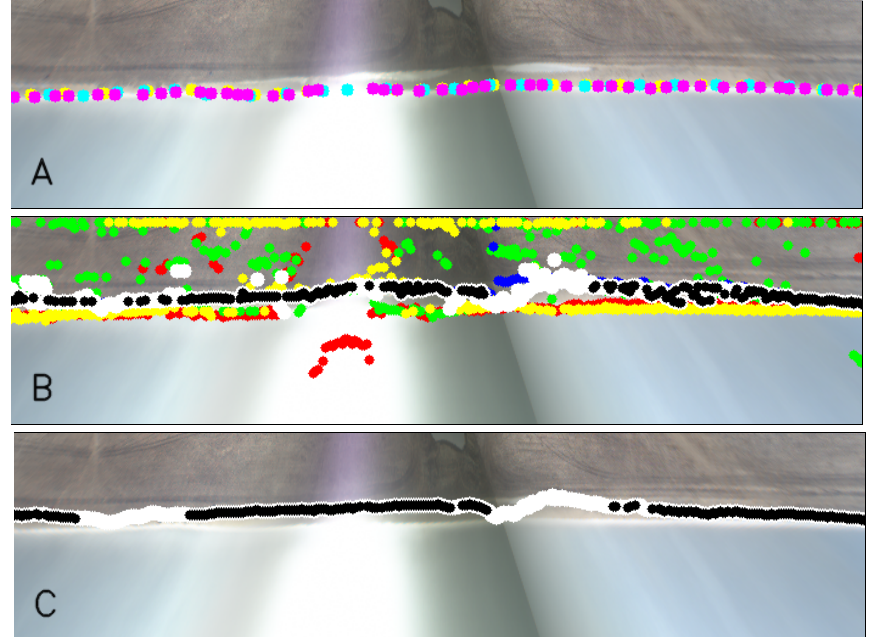
Figure 13. Equivalent to Figure 3, but of beach CFA1 on 15 December 2015 at 12 h. The images do not have the original size of the planview but a zoom is applied to facilitate the visualization. The presence of narrow wet areas in the dry beach misleads the